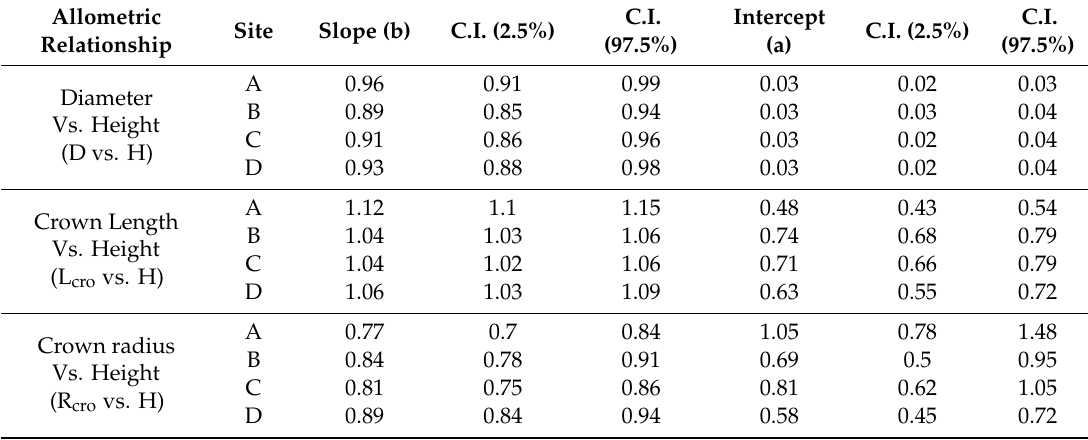
Table 6. Summary of the resulting a and b coe ffi cients and relative C.I. (confidence intervals, 95%) that describe the di ff erent allometric relationships in the four